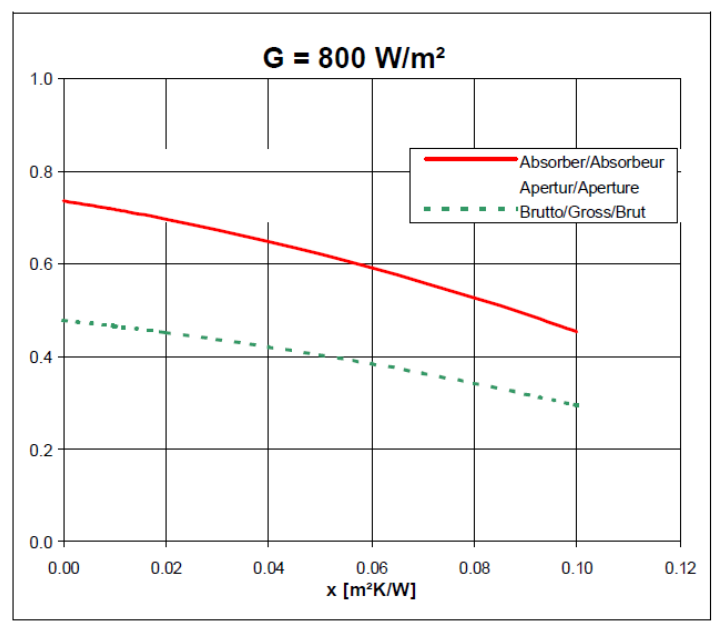
Figure 2. Sunda Seido 5 ‐ 16 efficiency curve, image from Solartechnik [16].